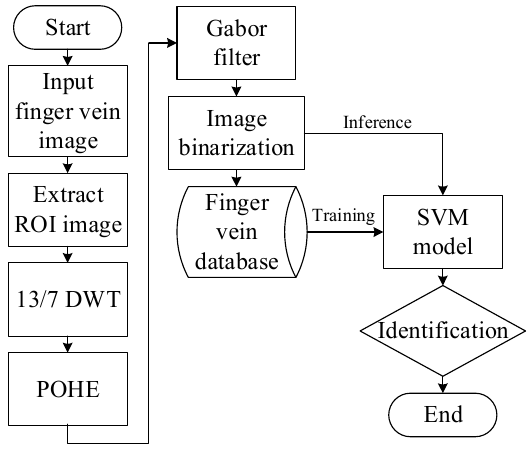
Figure 2. Flowchart of the finger-vein identification system.